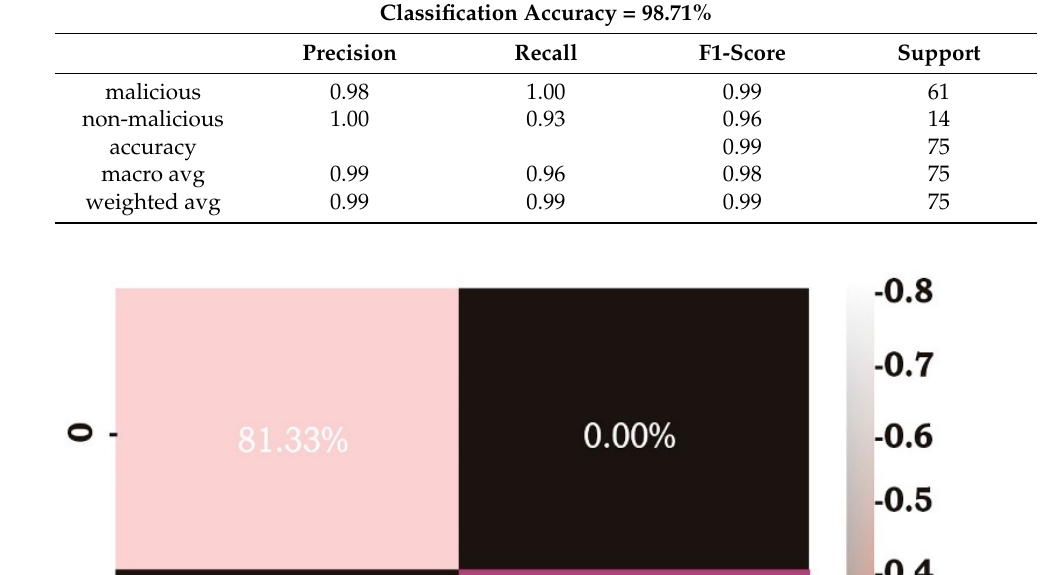
Figure A4. KNN classifier model summary with a confusion matrix. Table A4. AdaBoost classifier.